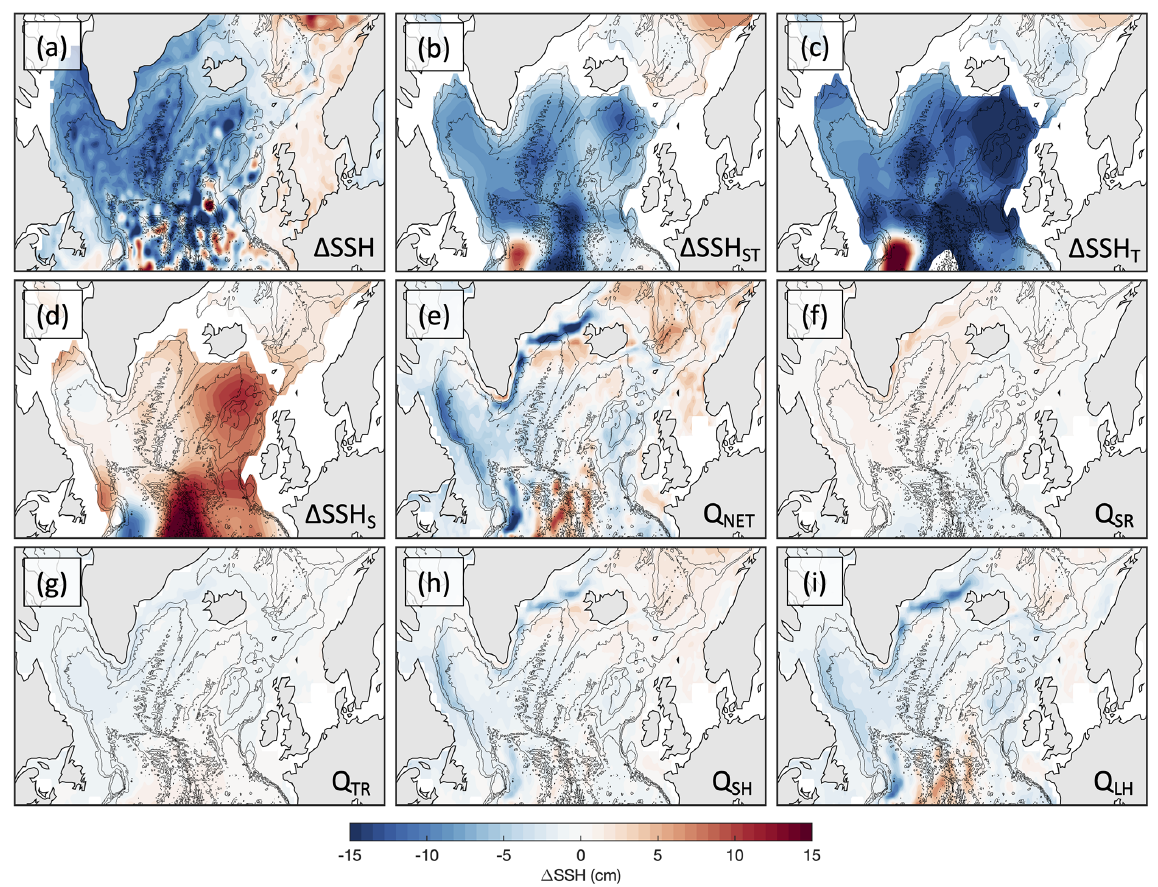
Figure 14. Same as Fig. 12 but for the 2011–2015 period.